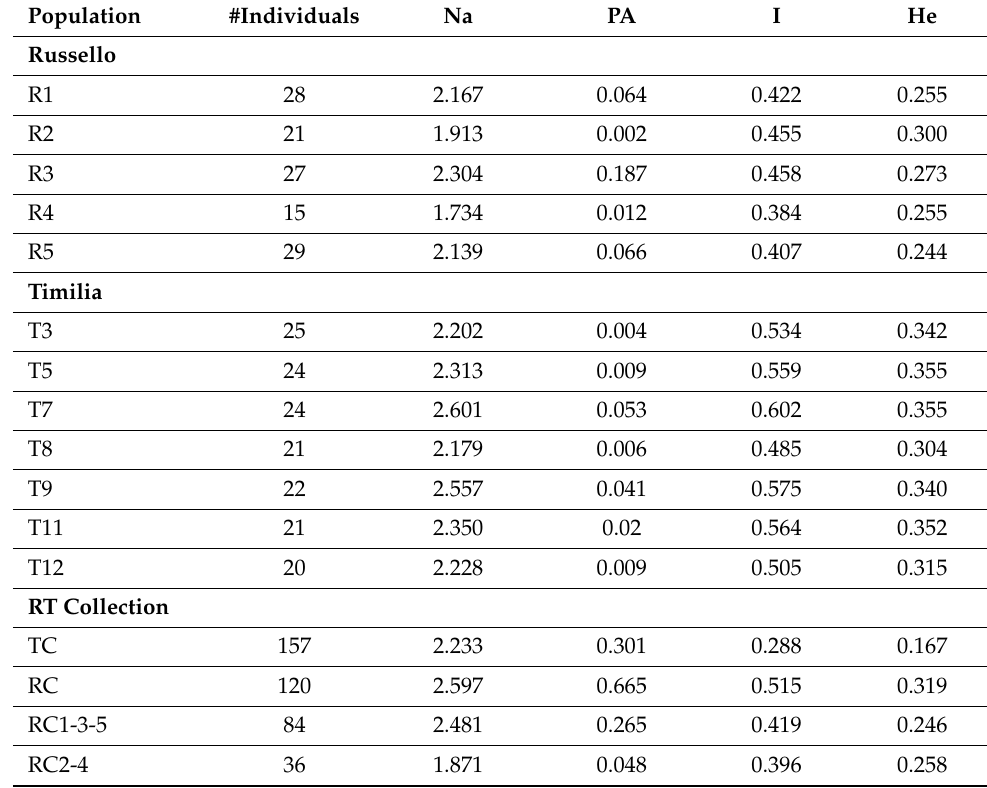
Table 1. Summary of genetic diversity and nucleotide variation indices calculated for each ”Russello” and “Timilia” populations and for the 3 RTC groups, after the removal of duplicate samples based on IBS values. Na = number of average alleles, I = Shannon’s index, PA = frequency of private alleles, He = Nei’s